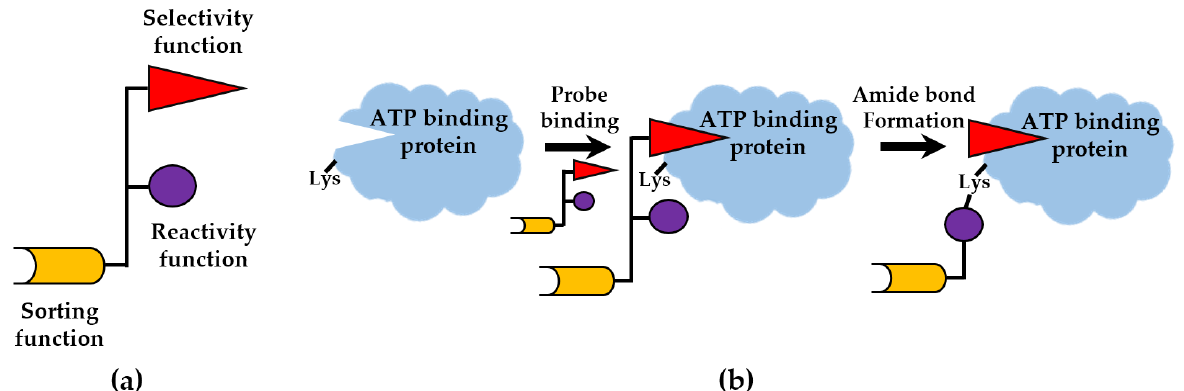
Figure 4. The principle of a chemical reactive probe. ( a ) Depiction of schematic kinome capture compounds; ( b ) A schematic diagram showing the conjugation between reactive ATP affinity probes with an ATP-binding protein including kinase.